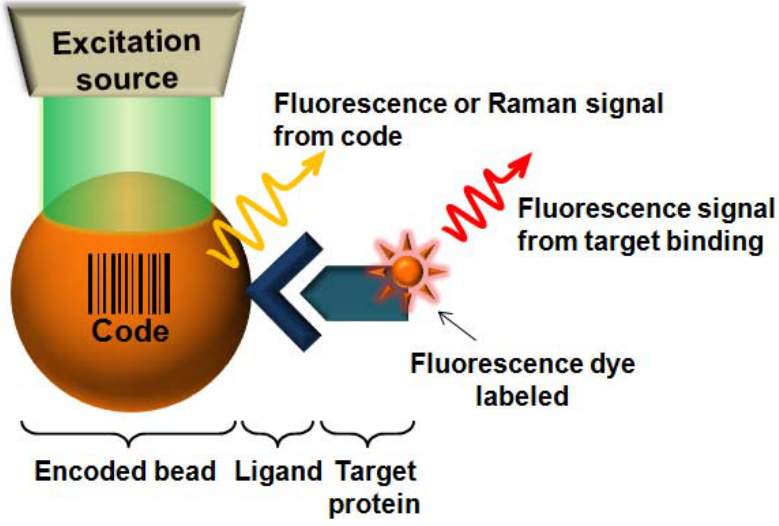
Figure 1. Schematic illustration of principle of a bead based